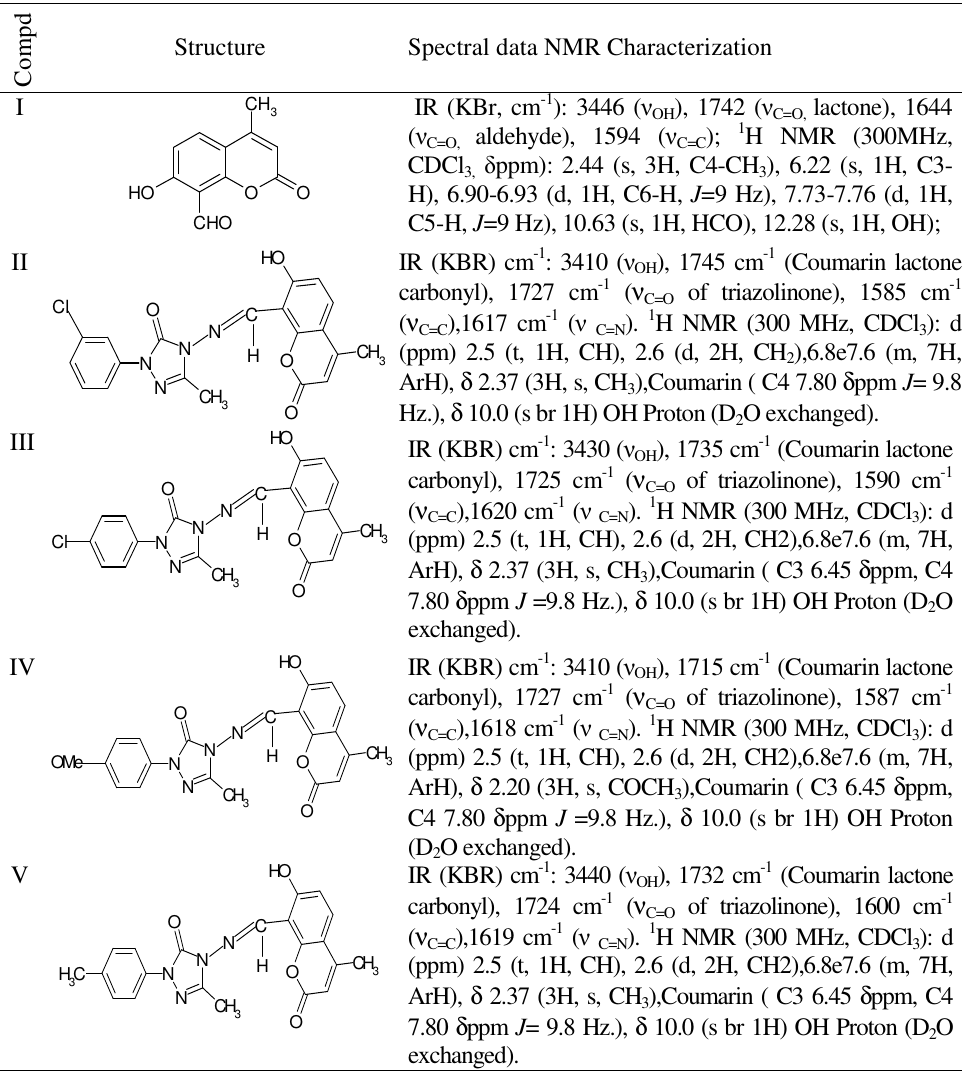
Table 2. Spectral data of the